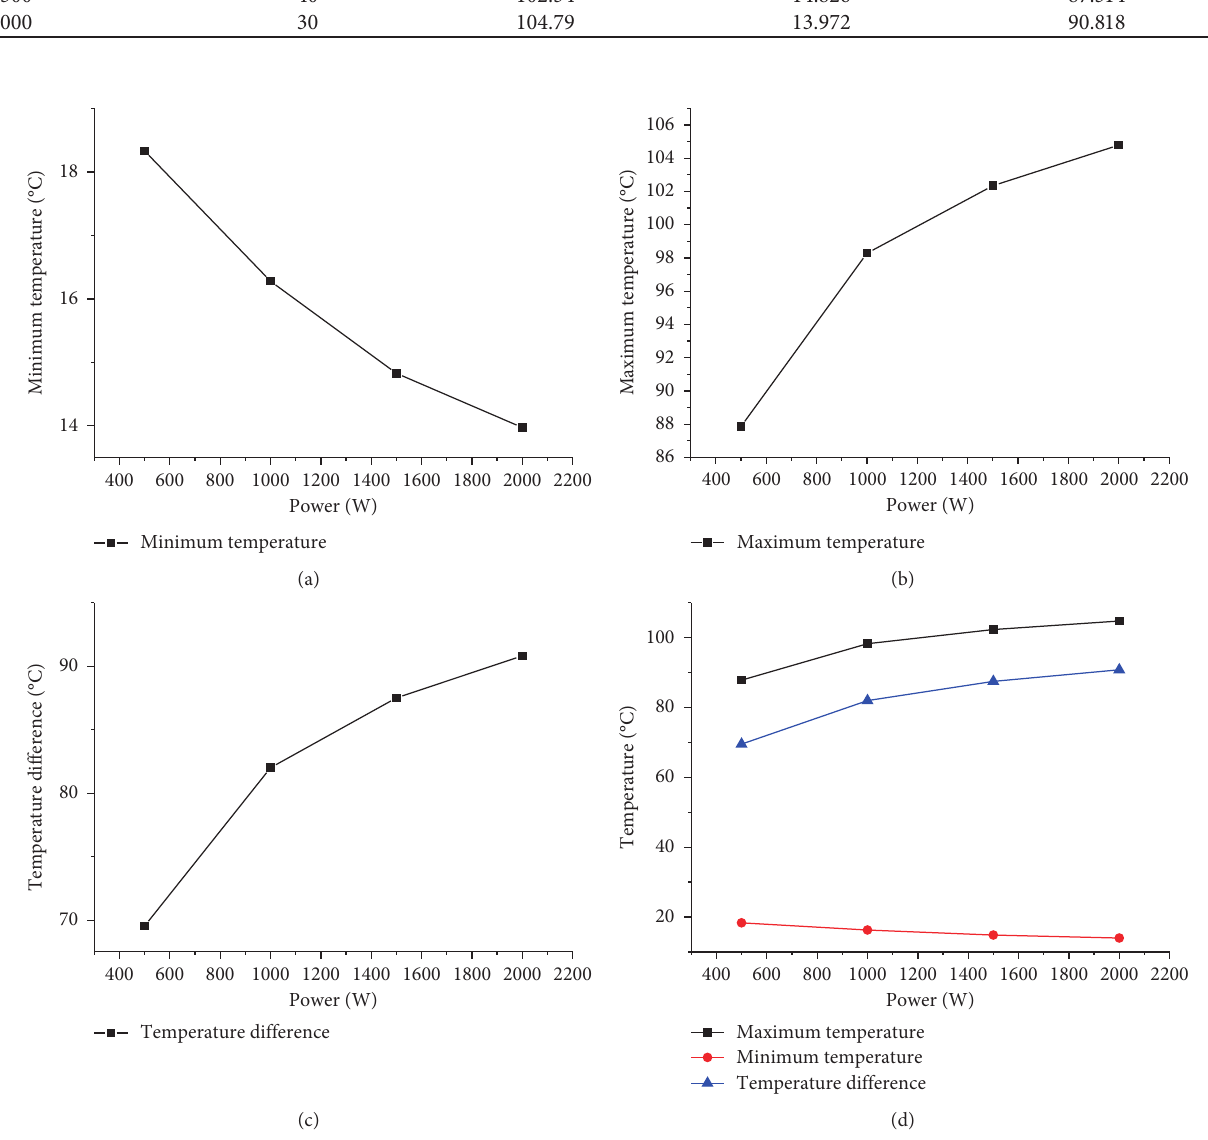
Figure 9: Comparison of microwave magnetic field temperature with the same energy